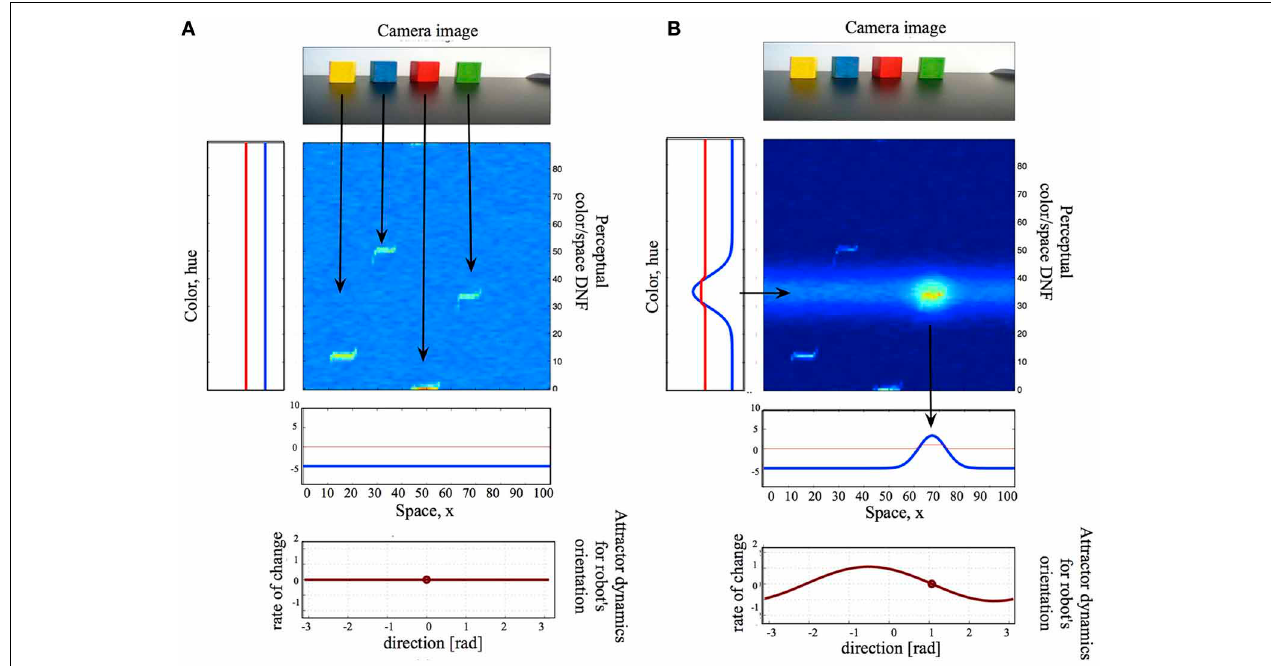
FIGURE 2 | A small DNF architecture, which consists of a two-dimensional color-space DNF (center), one-dimensional color- and space- DNFs, coupled to the perceptual DNF, a camera input (top), and an attractor motor dynamics (bottom). (A) The camera input alone is not sufficient to activate the perceptual DNF, the system is quiescent and produces neither output nor behavior. (B) A color cue creates an activity peak